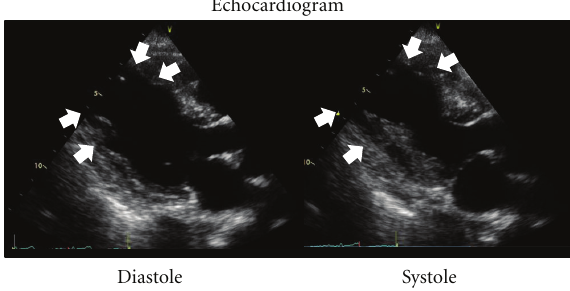
Figure 1: These images show echocardiography obtained at circulatory failure (41 hours after taking Basta) through cardiac cycle. There is akinesis lesion from mid to apex of left ventricle (LV) through cardiac cycle (white arrow). Meanwhile, there is hyperkinetic motion at base of LV.